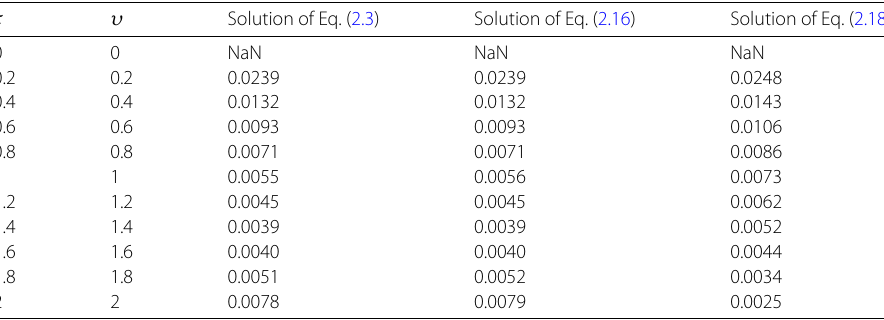
Table 1 Numerical values for equations (2.3), (2.16), and (2.18) τ υ Solution of Eq. (2.3) Solution of Eq. (2.16) Solution of Eq. (2.18)